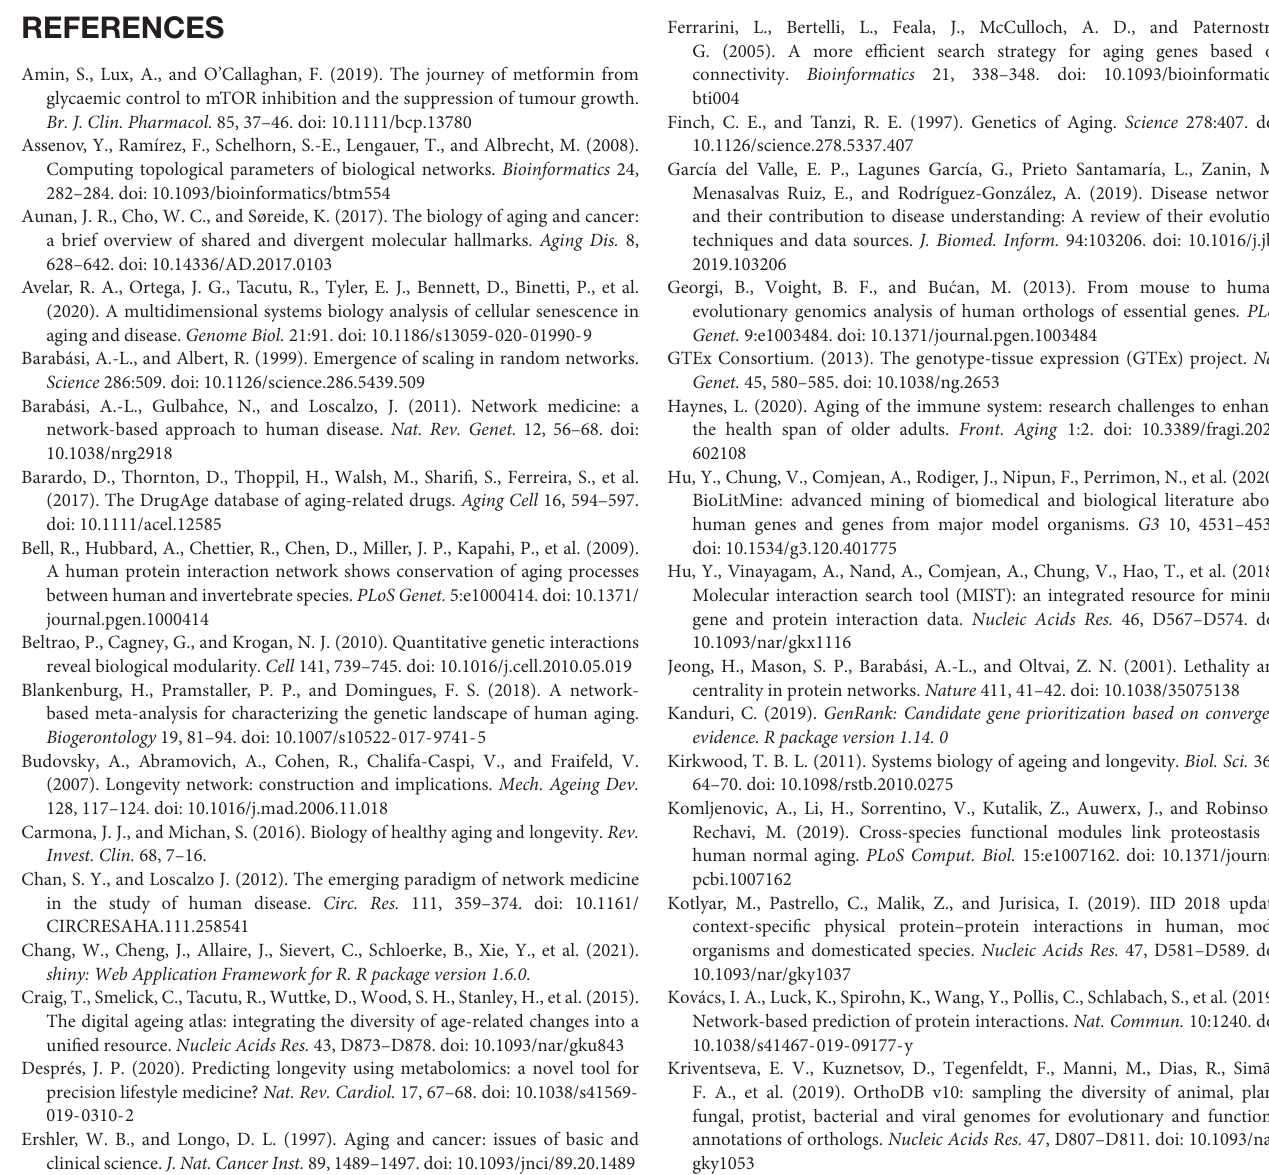
database. Elevated transcript level expressions were observed in heart, skeletal muscle and liver tissue in both the datasets. Supplementary Figure 6 | Comparison of the transcript and protein expression profiling. Both the transcript and protein level expression of genes were compared in four different human tissues: (A) liver, (B) heart, (C) skeletal muscle, and (D) adipose using the data from Human Protein Atlas (HPA) database. The X -axis indicates the normalized TPM values for the transcripts abundant and the Y -axis indicates the protein level expression values – Strong (1), moderate (0.50), weak (0.25), and negative (0) or no expression. To obtain the tissue expression of the proteins, we used the primary cell type specific expression (staining intensity) of the proteins. Supplementary Figure 7 | Cross-species PPIN topologies comparison for longevity drug targets. The degree (connecting topology) distribution of aging and